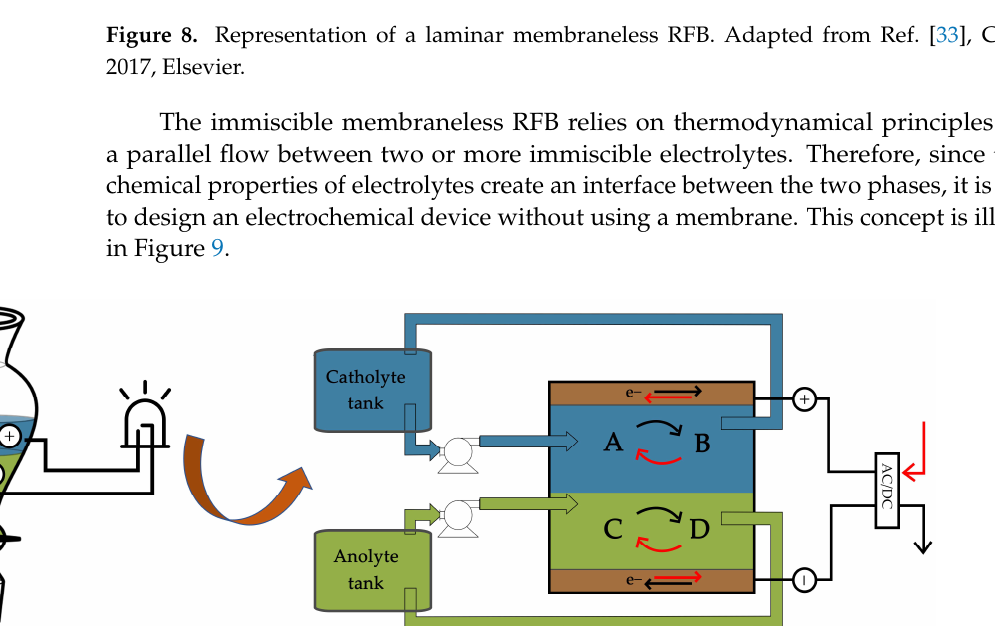
Figure 8. Representation of a laminar membraneless RFB. Adapted from Ref. [33], Copyright 2017, Elsevier.